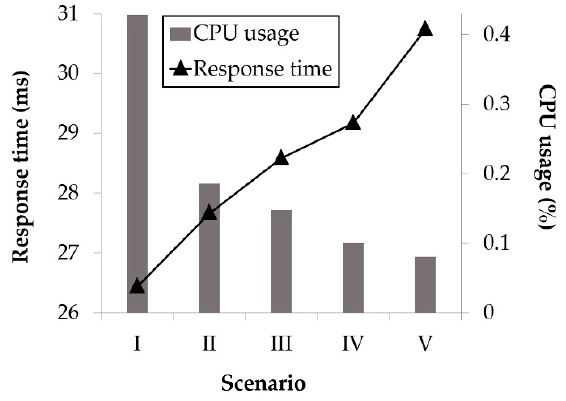
Figure 9. Edge device performance in terms of response time and CPU usage for different storing periodicity. Scenario details are provided in the main text above.